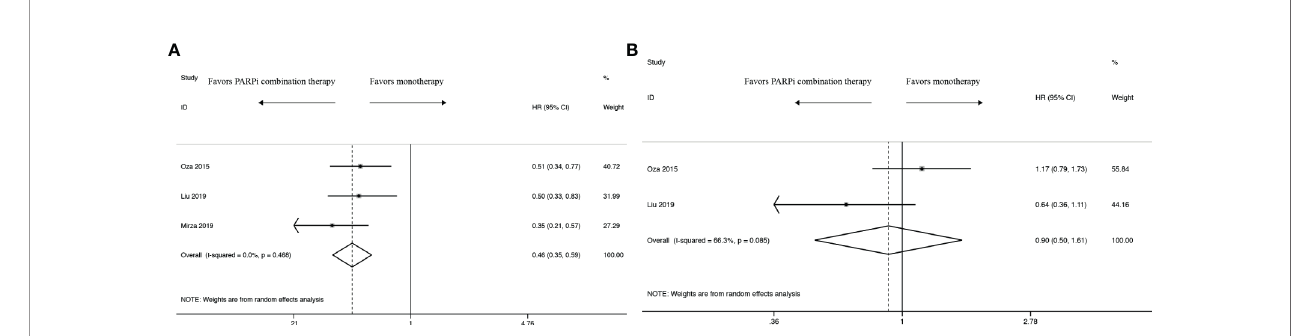
FIGURE 2 | Forest plot of the meta-analysis estimating the hazard ratios and 95% CI of progression-free survival (A) and overall survival (B) for patients assigned to intervention treatment, compared with those assigned to control